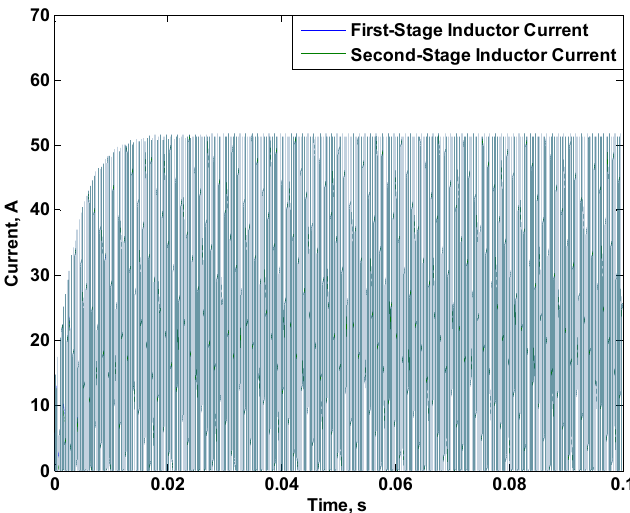
Figure 17. Output, first-stage capacitor and second-stage capacitor voltages at a reference voltage of 200 V.